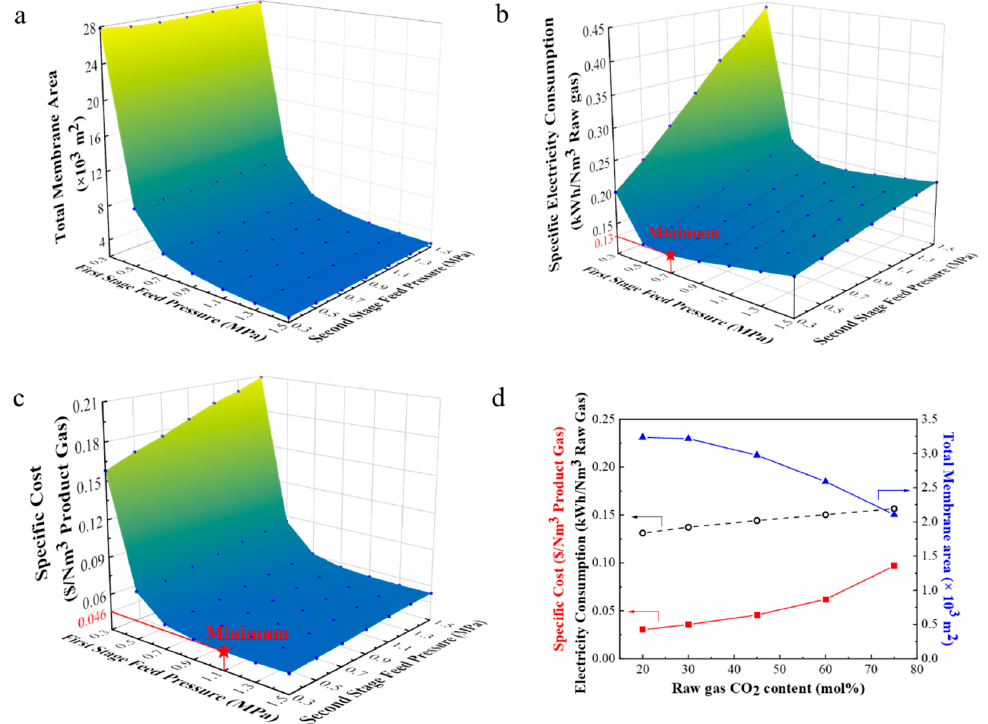
Figure 12. Simulation results of a two-stage membrane separation process using PPPS/PDMS/PSf composite membranes. Impact of the 1st- and 2nd-stage feed pressures on the total membrane area ( a ), the specific electricity consumption ( b ), and the specific cost ( c ). ( d ) Impact of CO 2 concentration on the specific cost, the specific electricity consumption, and the total membrane area, when the 1st- and 2nd-stage feed pressures are 1.1 and 0.3 MPa respectively.